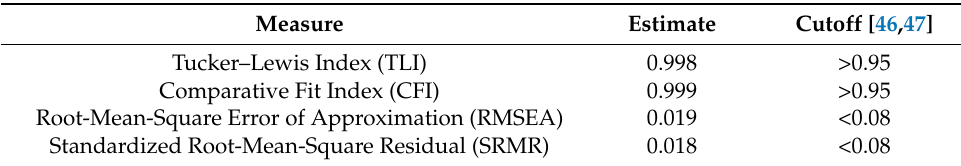
Table 8. Fit measures for Study